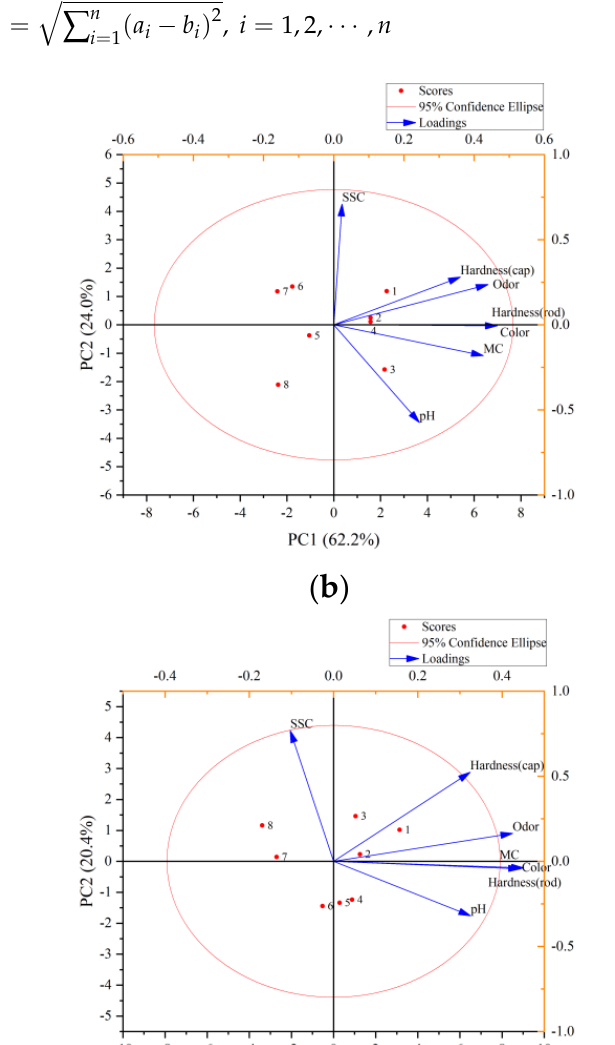
odor, pH, SSC and MC with the different packaging methods. They were divided into different clusters, so that the objects in the same cluster have great similarity, and the objects in the different clusters have great differences. Supposing the two n-dimensional data points are A = ( a 1 , a 2 ..., a n ) and B = ( b 1 , b 2 ..., b n ), then the Euclidean distance between A and B is: